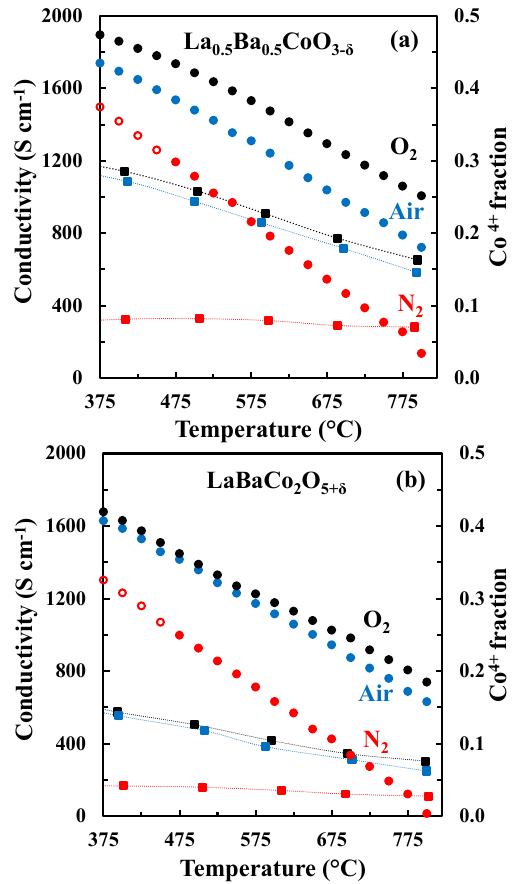
Figure 12. Electrical conductivity (squares) and Co 4+ fraction (circles) vs. temperature for La 0.5 Ba 0.5 CoO 3 ‐δ ( a ) and LaBaCo 2 O 5+ δ ( b ) in O 2 , air and N 2 . The open symbols are data out of equilibrium. The dotted lines are guides to the eye.